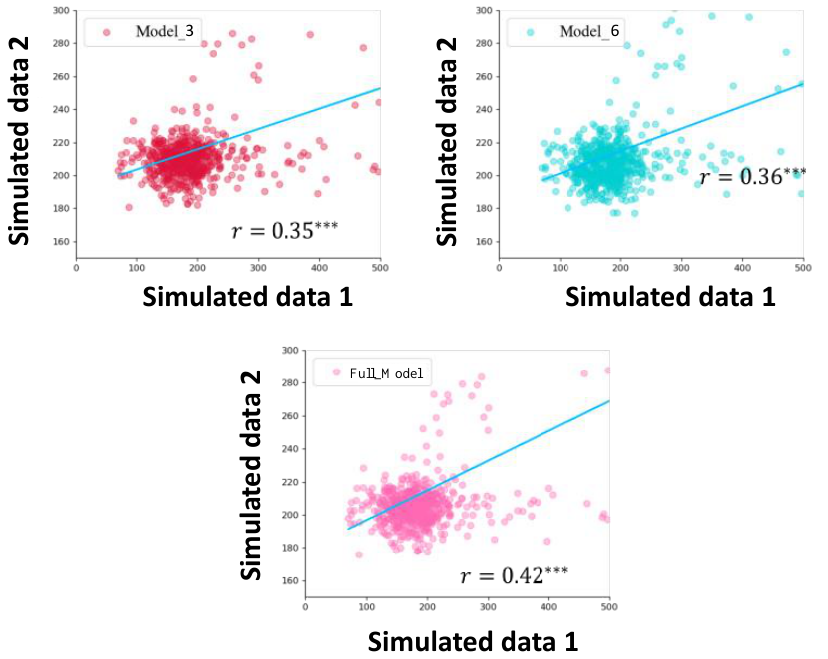
to decode new IM patterns, time-by-time (see Figure 8b).